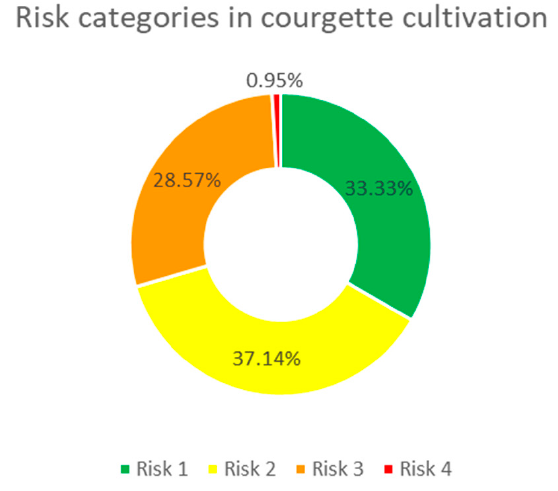
Figure 1. Risk categories in the postures adopted during courgette cultivation.